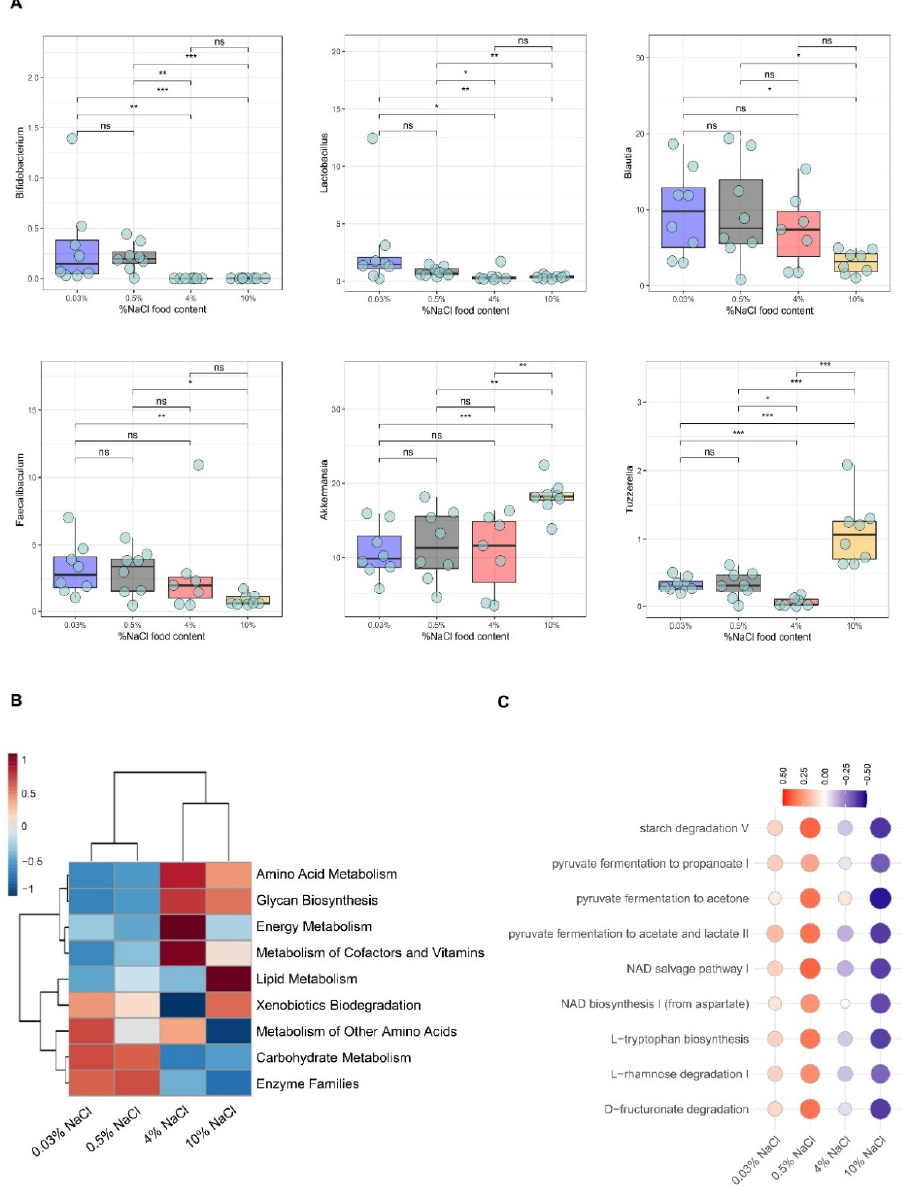
Figure 3. HSD associated with depletion of lactic acid ‐ producing bacteria. ( A ) Bacterial genera differentially represented in feces of mice fed on sodium ‐ deficient 0.03% NaCl, 0.5% NaCl (control), high salt 4% NaCl (HSD) and high salt 10% NaCl (HSD). ( B ) Predicted functional analysis of the gut microbiota using the PICRUSt software tool. Heat map shows the relative abundance changes of functional profile of gut microbiota among mice fed on sodium ‐ deficient 0.03% NaCl, 0.5% NaCl (control), high salt 4% NaCl (HSD) and high salt 10% NaCl (HSD). ( C ) The heatmap representing predicted function abundances per OTUs computed by PICRUST2 pipeline. The relative change of values indicated by color: red color shows an enrichment of the predictive function abundances, and blue indicates a depletion of the predictive function abundances (0.5% NaCl group was used as a control). * p ≤ 0.05—; ** p ≤ 0.01—; *** p ≤ 0.001. Our results suggest that high salt intake leads to alterations in the gut microbiota marked by a depletion of lactic acid ‐ producing bacteria and further overrepresentation of